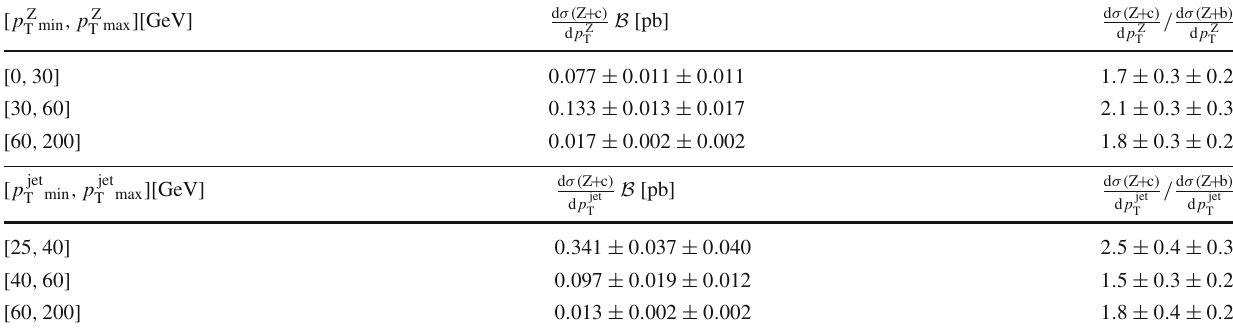
Table 4 Differential Z + c cross section and ( Z + c )/( Z + b ) cross sec- tionratio.Thefirstcolumnpresentsthe p T rangeforeachbin.Column2 presents the cross section and column 3 the ratio. The differential mea- surements as a function of the transverse momentum of the Z boson (jet